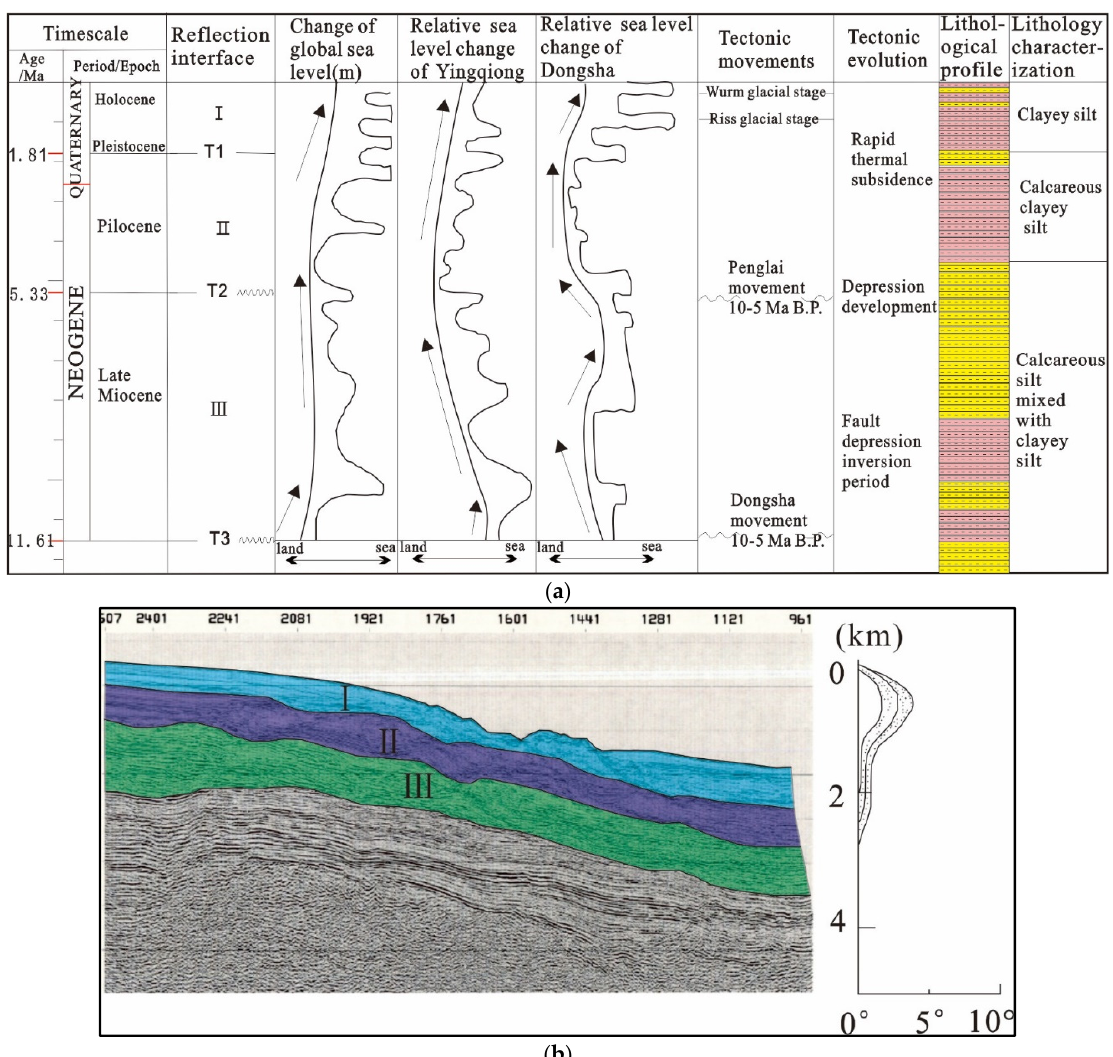
Figure 3. Comprehensive geological information in our model. ( a ) Composite columnar of the Dongsha area, including the tectonic sequence classification scheme since the Late Miocene. ( b ) Three latest sequences corresponding to the above chart ( a ). Red arrow line in Figure 2a within part of shallow slope surface identified through seismic profile, which generally produces GH layers, is shown on left side; right side is calculated slope angle